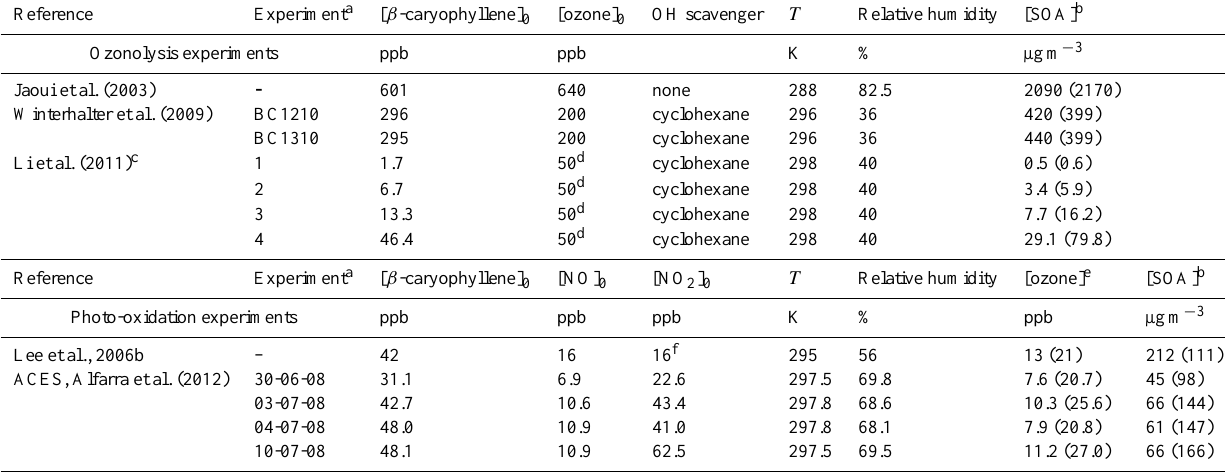
Table 1. Summary of experimental datasets used to evaluate the MCM v3.2 β -caryophyllene